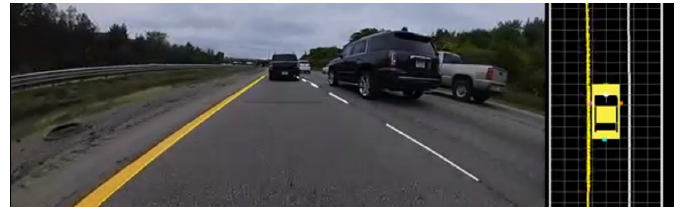
Figure 3. Example of road marking detection.